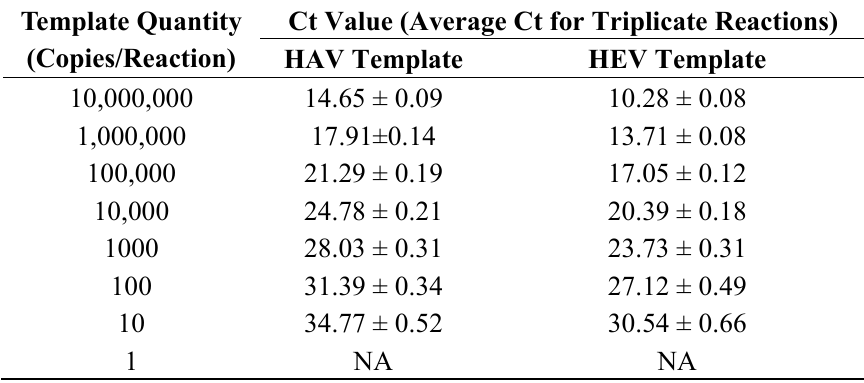
Table 2. Sensitivity analysis of HAV-HEV multiplex real-time